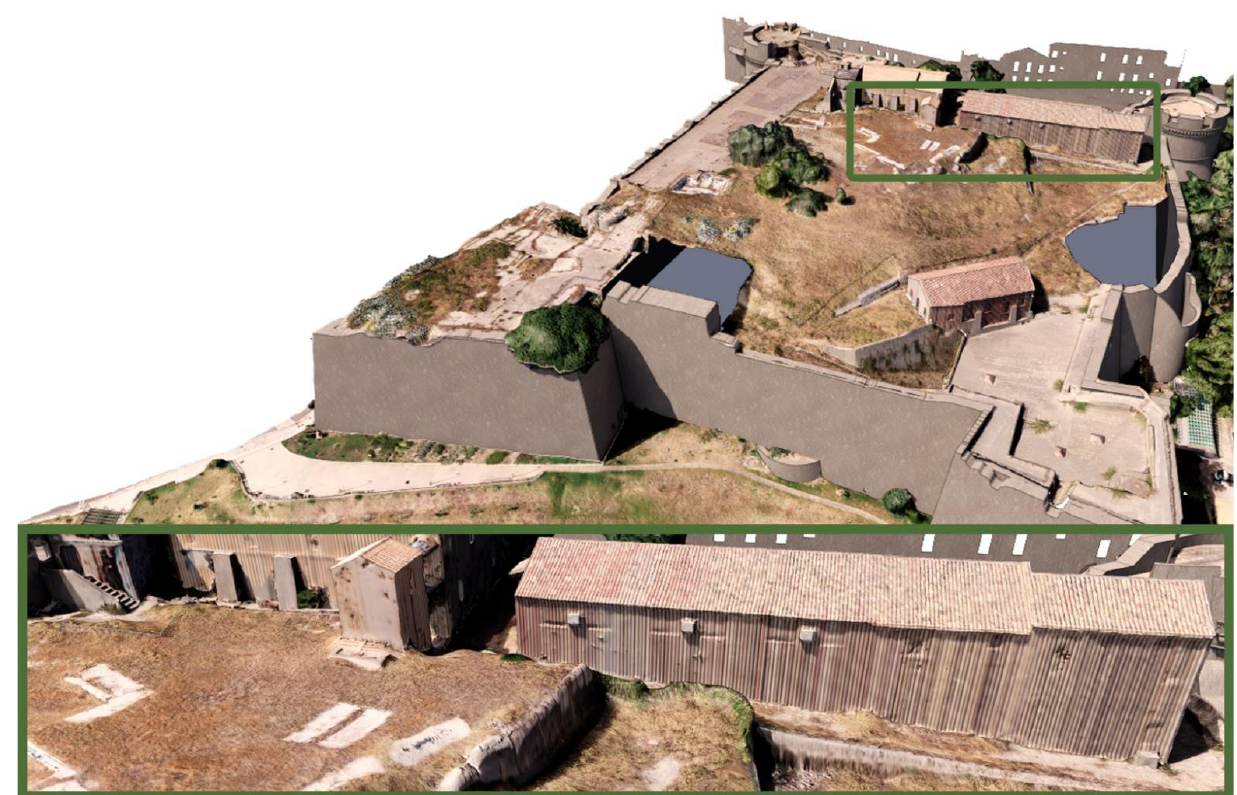
Figure 10. Results and issues, in the vertical elements texturing, posed by the Workflow A imple-